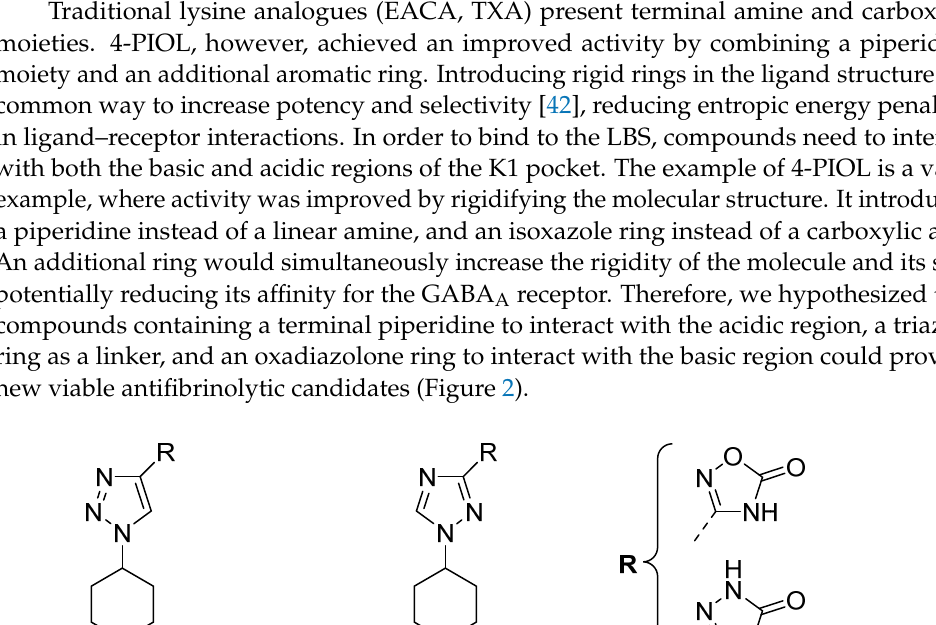
Figure 1. Previously studied small molecules with antifibrinolytic activity by inhibition of the lysine binding sites of plasminogen.